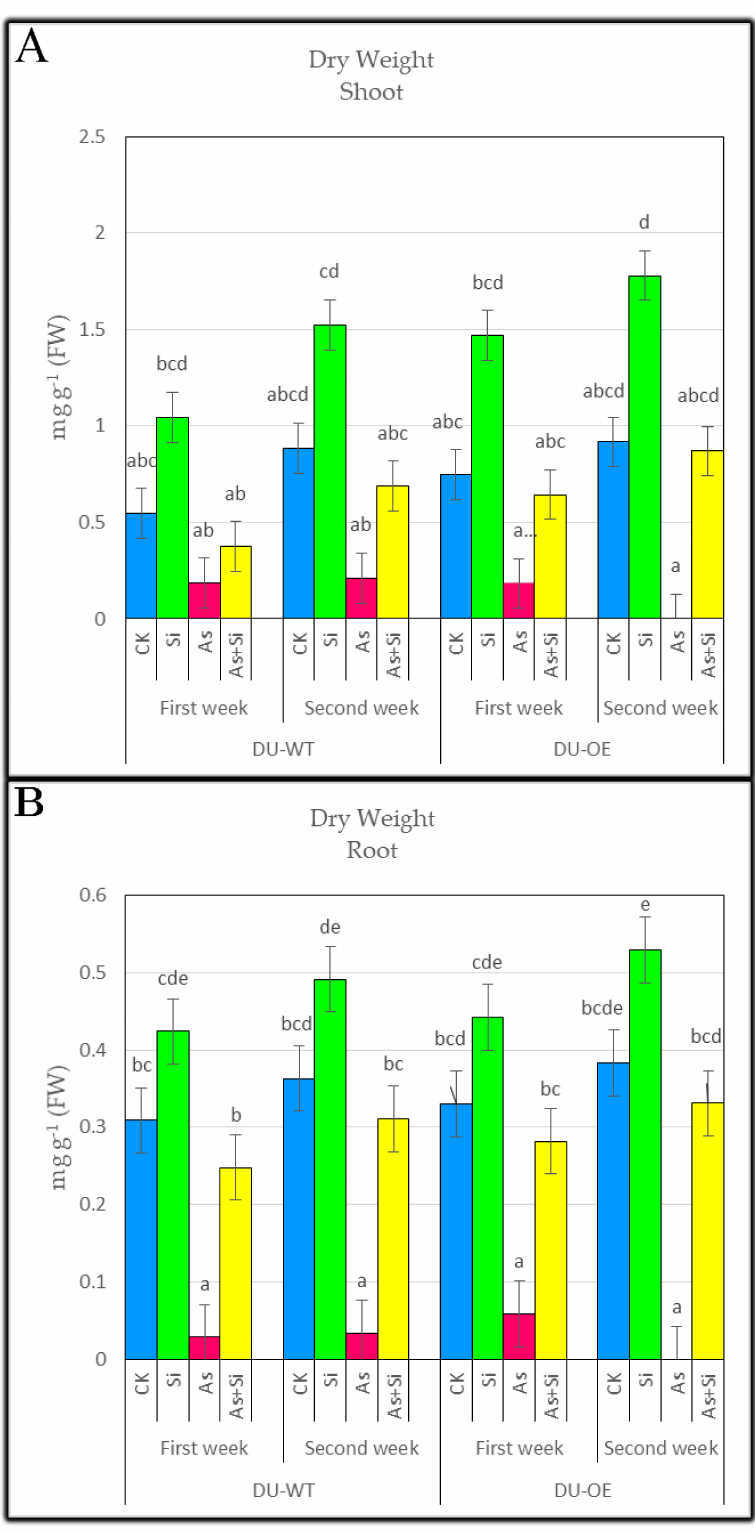
Figure 3. The dry weight of DU-WT and DU-OE shoots, the first and second weeks after adding treatments ( A ); the dry weight of DU-WT and DU-OE roots, the first and second weeks after adding treatments ( B ). The different letters on the bars indicate a significant difference among independent treatment ( p ≤ 0.05); (FW: fresh weight; CK: control; Si: 0.70 mM Si; As: 30 µ M As; As+Si: 30 µ M As + 0.70 mM